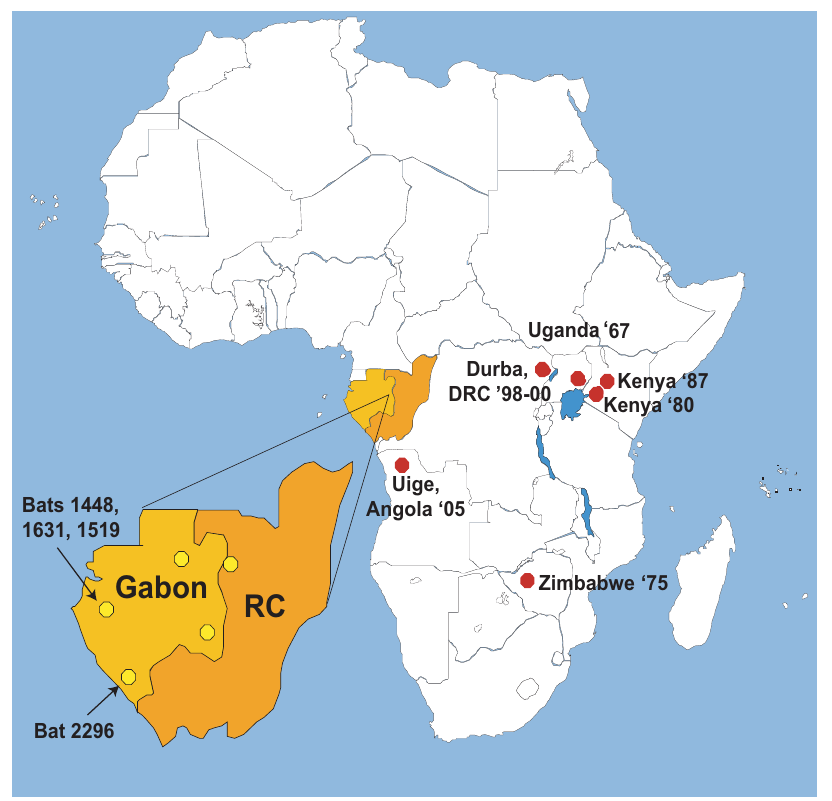
Figure 1. Animal collection sites in Gabon and Republic of Congo. Animal trap locations in Gabon and Republic of Congo (expansion) are indicated by yellow circles. Also indicated are the locations of the four PCR positive bats (by arrows) and the dates and locations of all known origins of previous Marburg virus outbreaks (red circles). doi:10.1371/journal.pone.0000764.g001 PLoS ONE | www.plosone.org